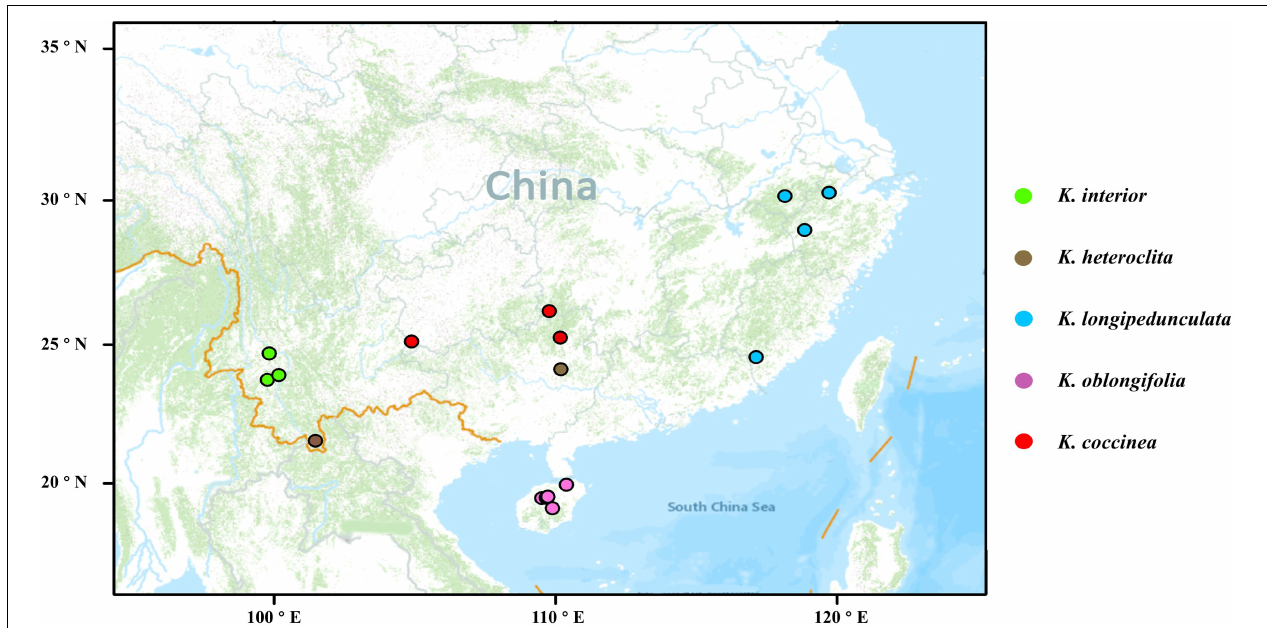
FIGURE 1 | Sample distribution of the five species of Kadsura. The base map was generated by ArcGIS